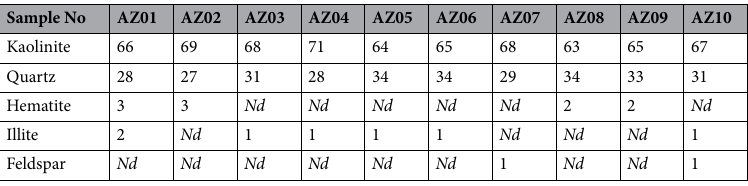
Table 2. The mineralogical compositions of the studied bulk samples (wt%). Nd not